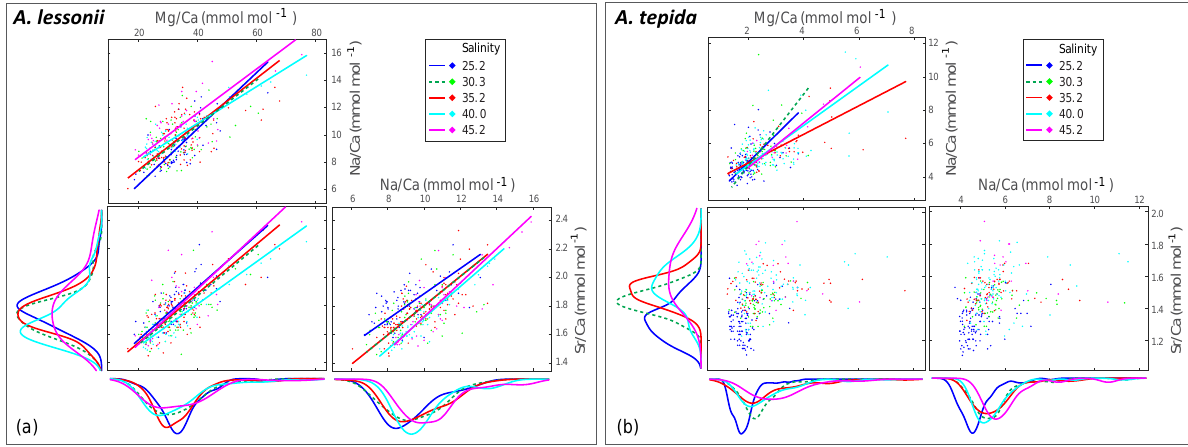
Figure 2. Individual chamber LA-ICP-MS analyses showing correlations between foraminiferal Mg / Ca cc , Sr / Ca cc and Na / Ca cc for A. tepida (a) and A. lessonii (b) per salinity condition. Significant orthogonal linear regressions are indicated with a line, colour coded for salinity (see legend). Correlation coefficients, slope and intercepts of these regressions can be found in Supplement S3. In short, within salinity conditions, element ratios are strongly correlated with each other in A. lessonii , whereas in A. tepida , element ratios do not (strongly) correlate with each other. When combining all single-spot data in A. tepida , element ratios correlate amongst each other because the incorporation of all three elements increases with salinity, shifting the distributions to higher values. In A. lessonii , only the Na / Ca cc distributions shift towards higher values with increasing salinity, whereas Mg / Ca cc and Sr / Ca cc distributions are relatively similar between salinity conditions.